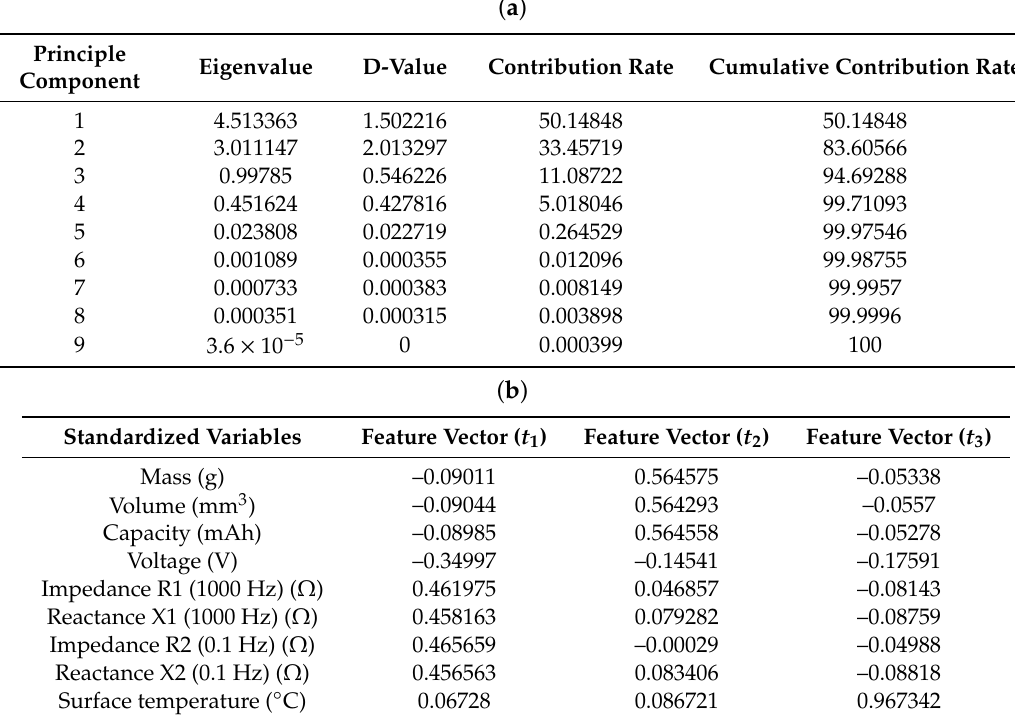
Table 3. ( a ) Principal component analysis of 58 batteries with nine parameters. ( b ) Proportional relationship between the original parameters and principal